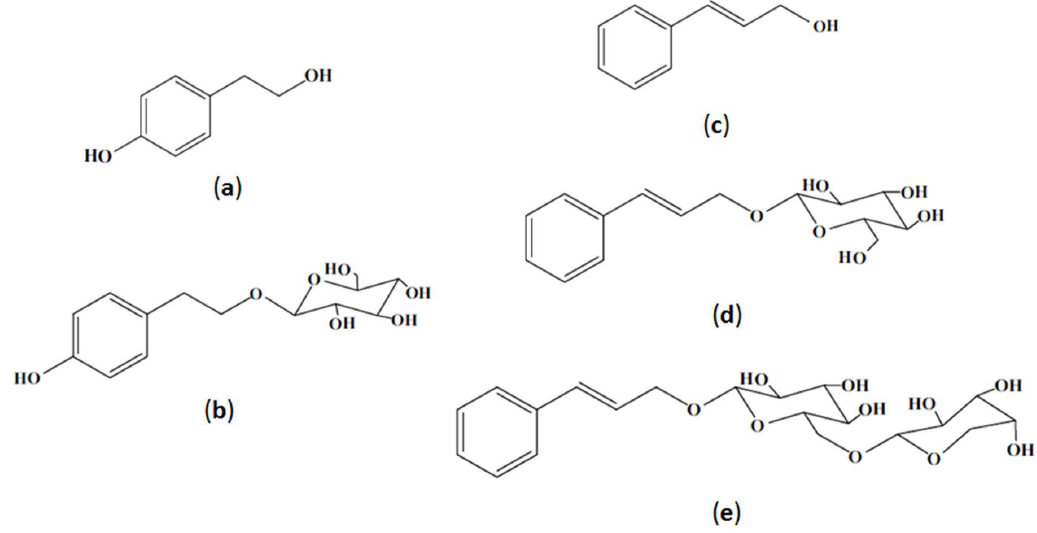
Figure 1. The most important markers of R. rosea : ( a ) tyrosol; ( b ) salidroside; ( c ) cinnamyl alcohol; ( d ) rosin; and ( e ) rosavin.